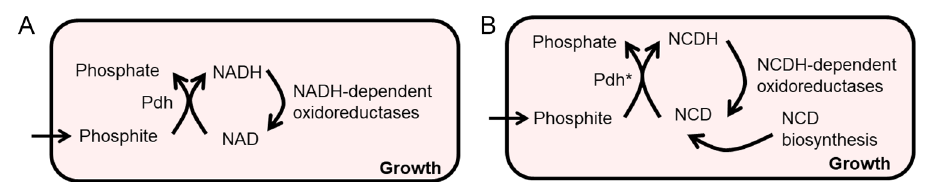
Figure 2. Schematics of phosphite-based selection system. ( A ) Phosphite was oxidized by Pdh and a closed redox loop was formed with NADH-dependent reactions to support growth of E. coli ( ∆phn, ∆phoA ) with phosphite as the sole phosphorous source. ( B ) A closed NCD redox cycle promotes phosphite metabolism to support growth with phosphite as the sole phosphorous source. Phosphite cannot be oxidized in the absence